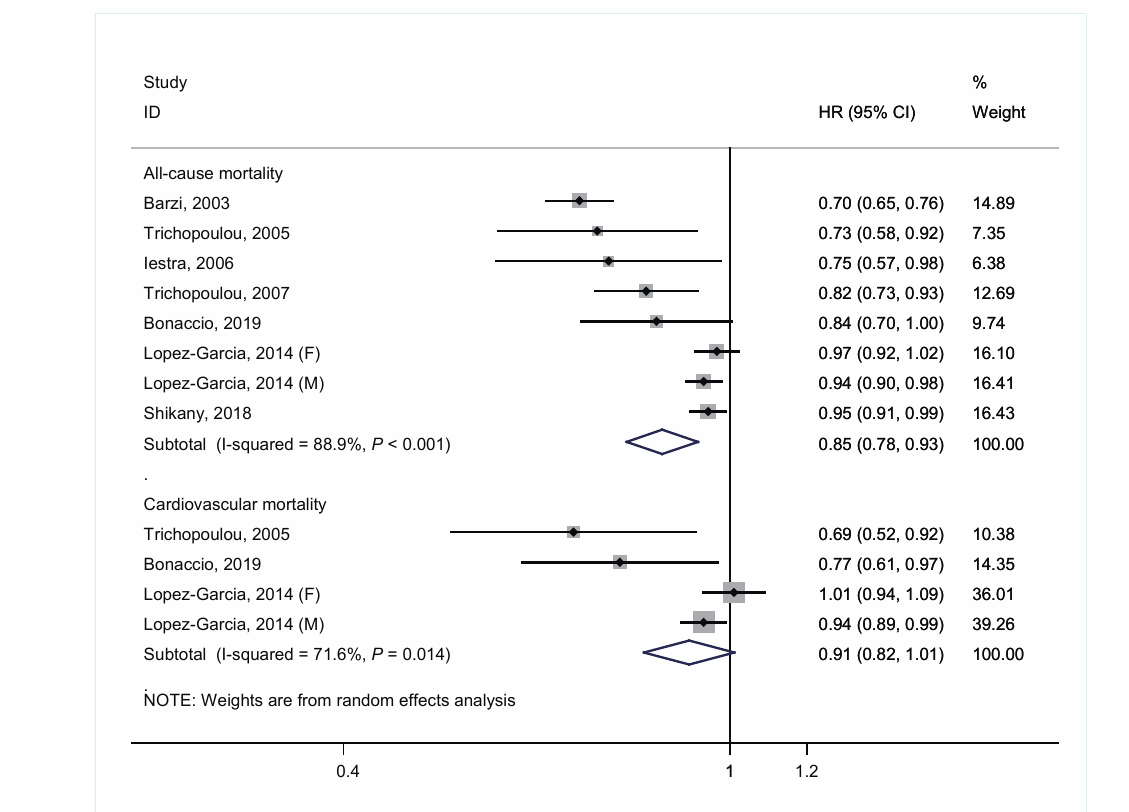
Figure 2. Meta-analysis of associations of each 2-unit increment in a score of adherence to Mediterranean diet with all-cause and cardiovascular mortality in people with a history of cardiovascular disease.